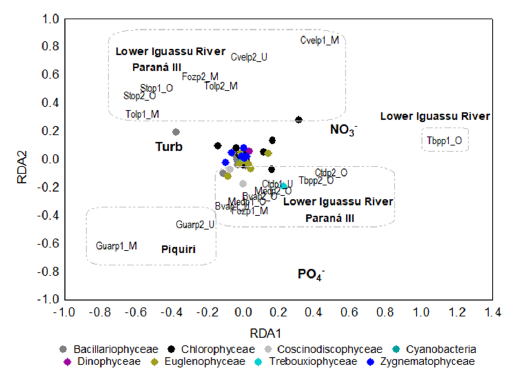
Figure 5. Redundancy analysis performed with biovolume species, rivers sampled and environmental variables (Nitrate - NO 3- ; turbidity -Turb; orthophosphate - PO 4- ; Mesotrophic -M; Oligotrophic – O; Ultraoligotrophic – U; Bva - Boa Vista da Aparecida; Ctd – Catanduvas; Cvel – Cascavel; Foz - Foz do Iguaçu; Guar – Guaraniaçu; Med – Medianeira; Sto - Santa Tereza do Oeste; Tbp - Três Barras do Paraná; Tol – Toledo; 1 - headwaters; 2 - water catchment